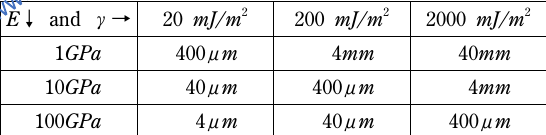
Table 1 Particle diameter below which plastic deformations occur at